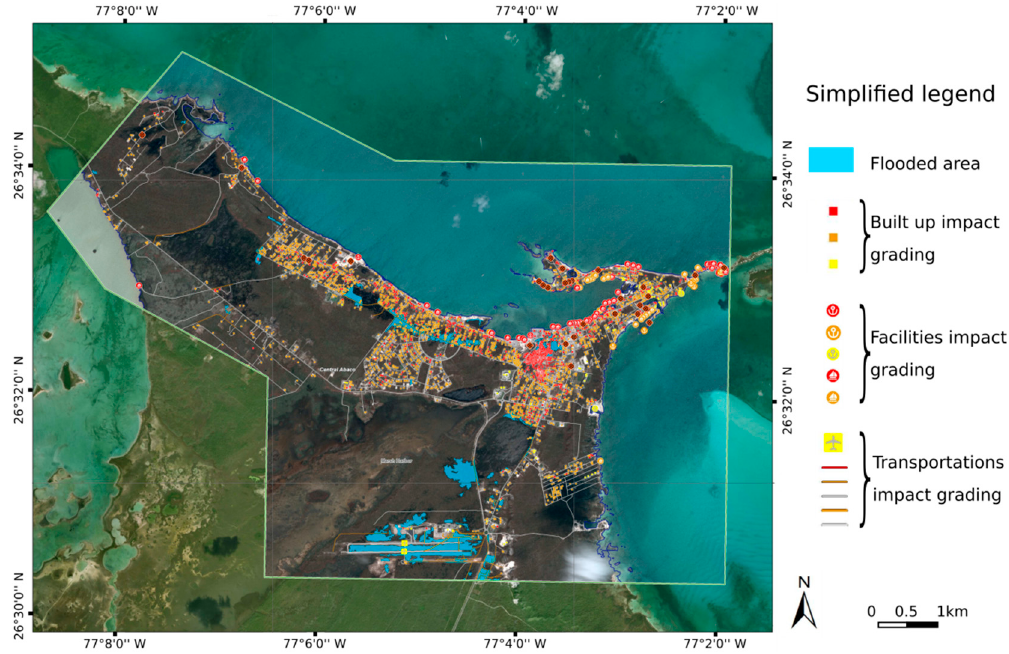
Figure 3. Simplified EMSR385 map from the full-resolution original Copernicus product.